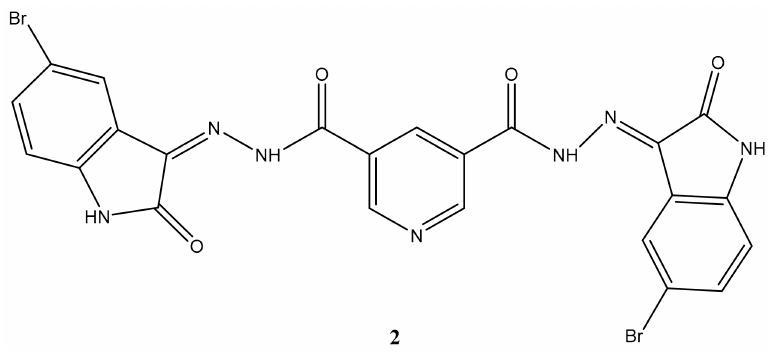
Figure 4. The structure of 2 . (IC50 = 23.73 µ mol/L, HCT-116). A series of novel pyrano[3,2-a]phenazine derivatives (Figure 5), designed as hybrid molecules of phenazine and pyran pharmocophores and then treated with compounds at concentrations from 0 to 50 µ mol/L. Cytotoxic evaluation indicates that many compounds exhibited cytotoxicity against HCT116, MCF7, HepG2 and A549 cancer cell lines in vitro, in which compounds 1c , 1i , 2e , and 2l were found to have excellent antiproliferative activity against the HepG2 cancer cell line [35]. This provided the experimental basis for the further mechanism of 3a – 3j and its influence on tumor